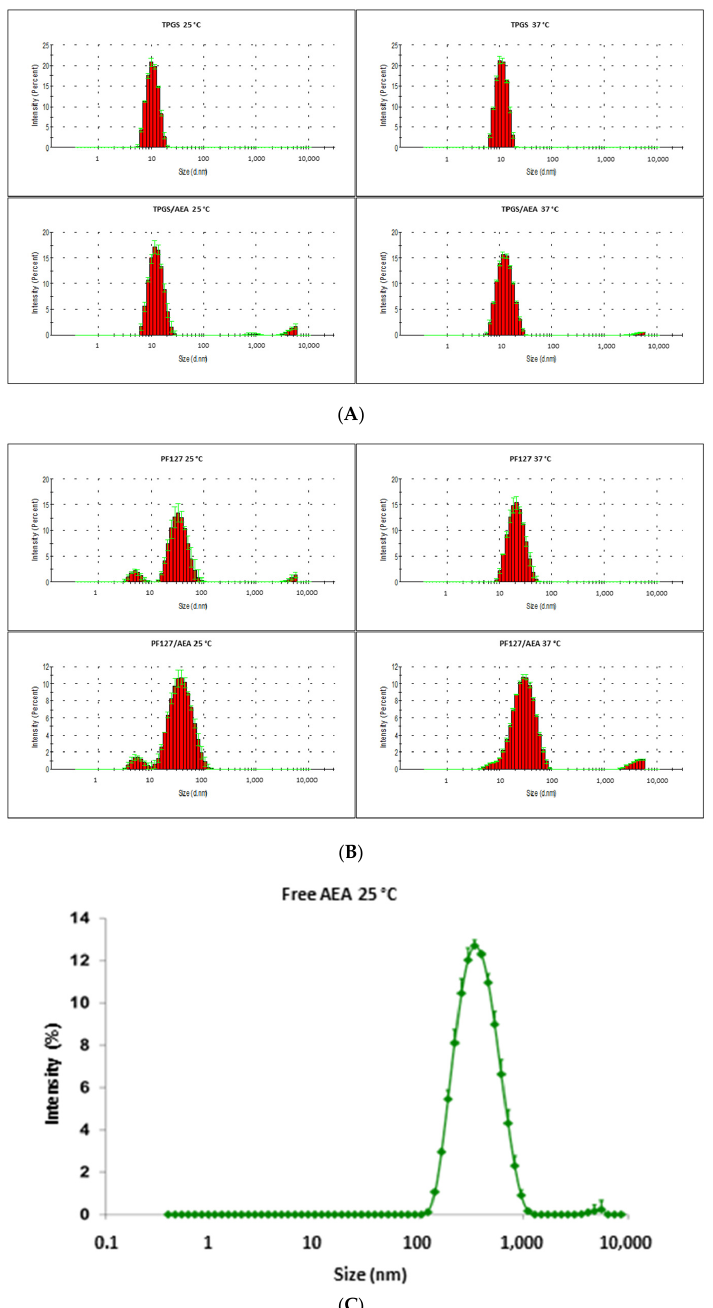
Figure 2. ( A ) Particle size distribution: DLS graphs of TPGS nanomicelles with and without AEA at 25 °C and 37 °C. ( B ) Particle size distribution: DLS graphs of PF127 nanomicelles with and without AEA at 25 °C and 37 °C. ( C ) DLS graphs of free AEA freshly dispersed in aqueous solution at 25 °C.